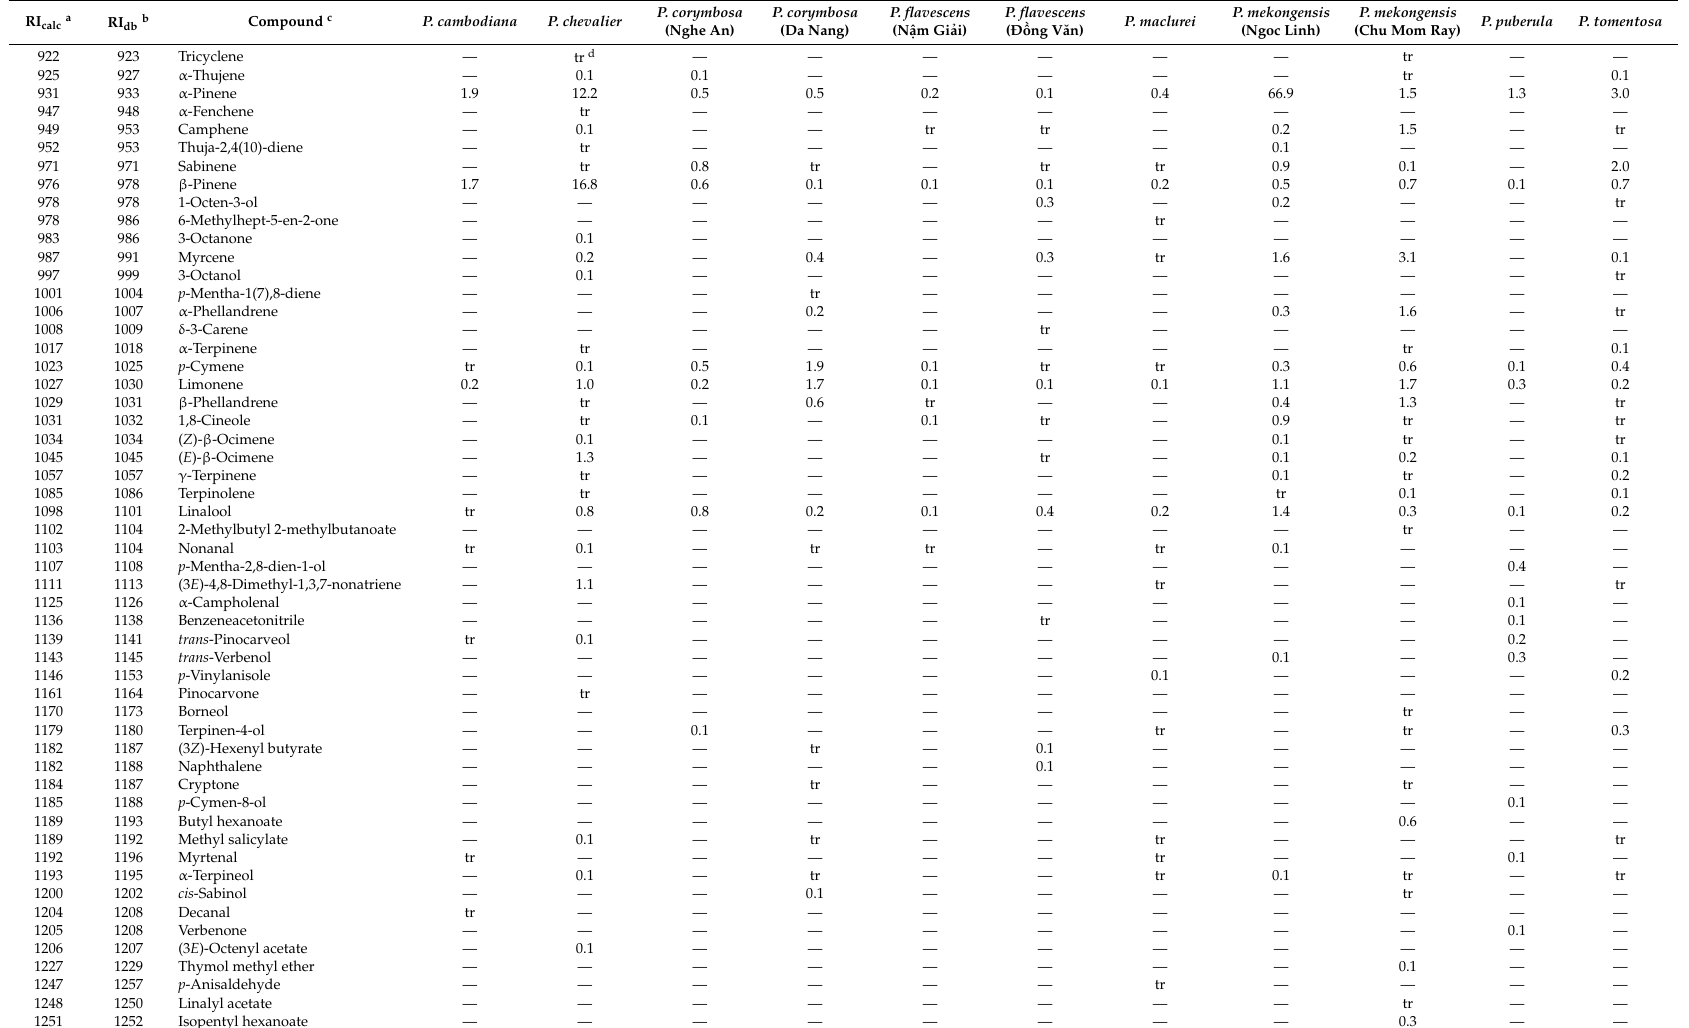
Table 3. Chemical compositions of leaf essential oils of Premna species from central